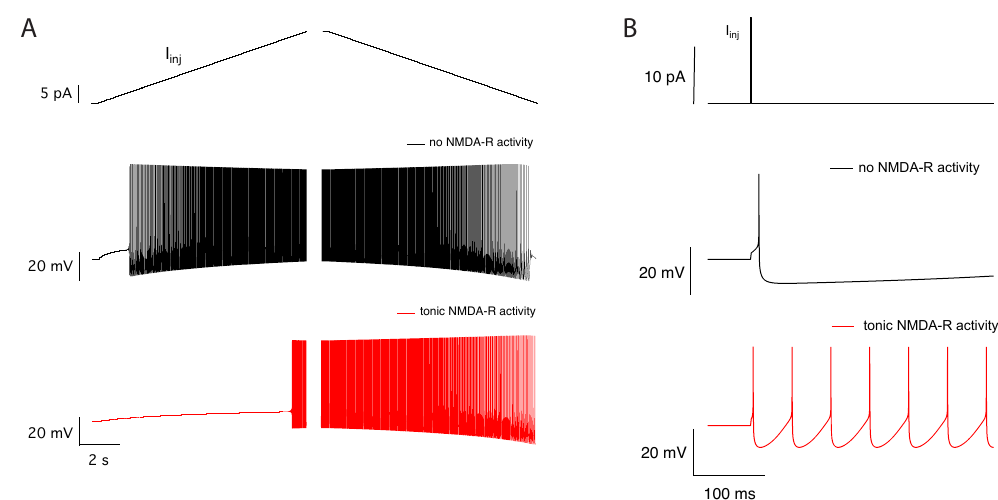
Figure 5. Tonic NMDA-R activity increases the hysteresis observed during a stimulation by a ramp or by a pulsed current injection. ( A ) The applied stimuli consist of a ramp of injected current from 0 pA to 20 pA or from 20 pA to 0 pA, during 10 s. The presented solutions correspond to a situation where the system starts from the stable steady-state at 0 pA or from the stable limit cycle at 20 pA. In absence of tonic NMDA-R activity, the threshold current for spike generation is nearly similar for increasing or decreasing ramp stimuli (black trace). In presence of tonic NMDA-R activity, the threshold current for spike generation greatly differs for increasing or decreasing ramp stimuli (red trace). Note that, in absence of tonic NMDA-R activity, the system goes back to the stable steady-state when submitted to the decreasing ramp stimulus but, when the receptors are active, it is still oscillating when it reaches 0 pA of injected current. ( B ) The applied stimuli consist of a single pulse of injected current from 0 pA to 15 pA, during 1 ms. In absence of tonic NMDA-R activity, a single spike is elicited (black trace). In presence of tonic NMDA-R activity, the short current pulse induces sustained spiking (red